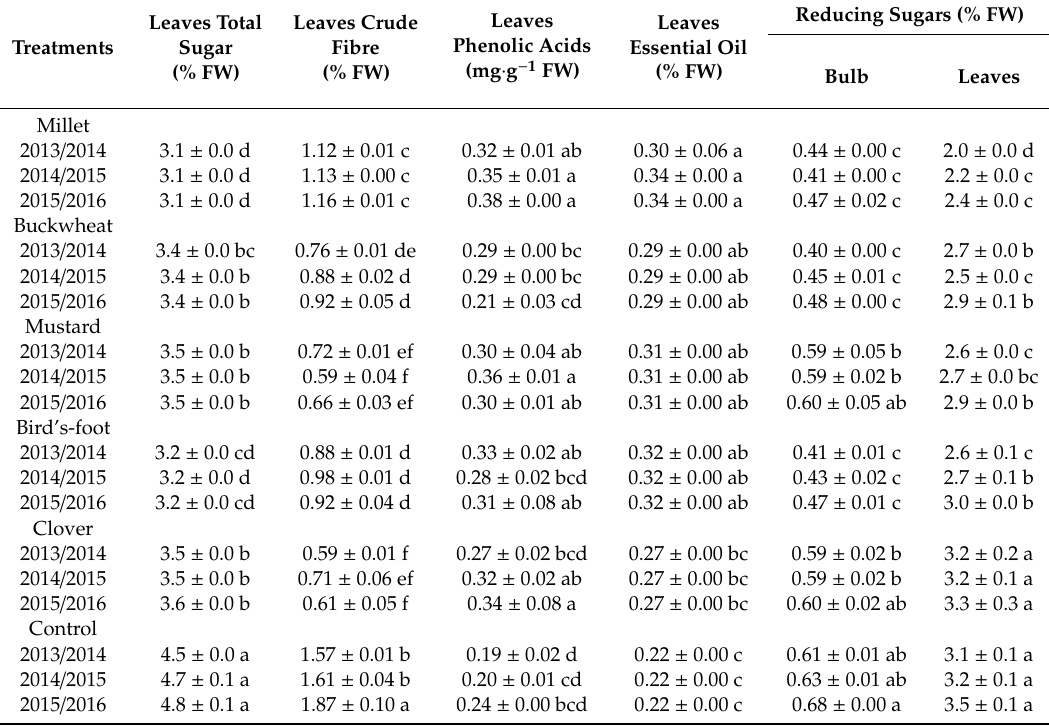
Table6. Chemicalcompositionofwintergarlicediblepartsasa ff ectedby‘mulchtype × year’interaction.